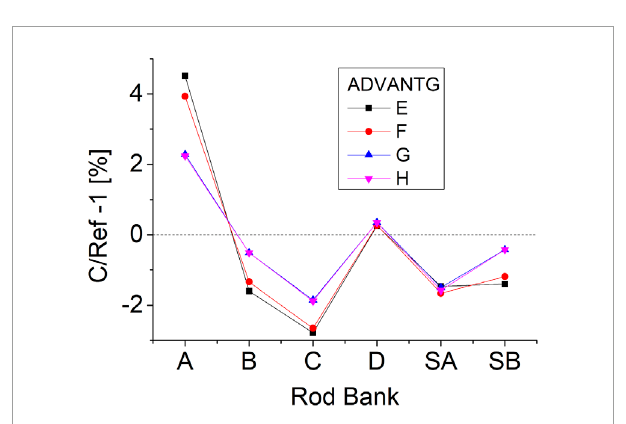
FIGURE 14 Difference in the reaction rate redistribution factors from ADVANTG/Denovo calculation of adjoint neutron flux from the reference direct MCNP